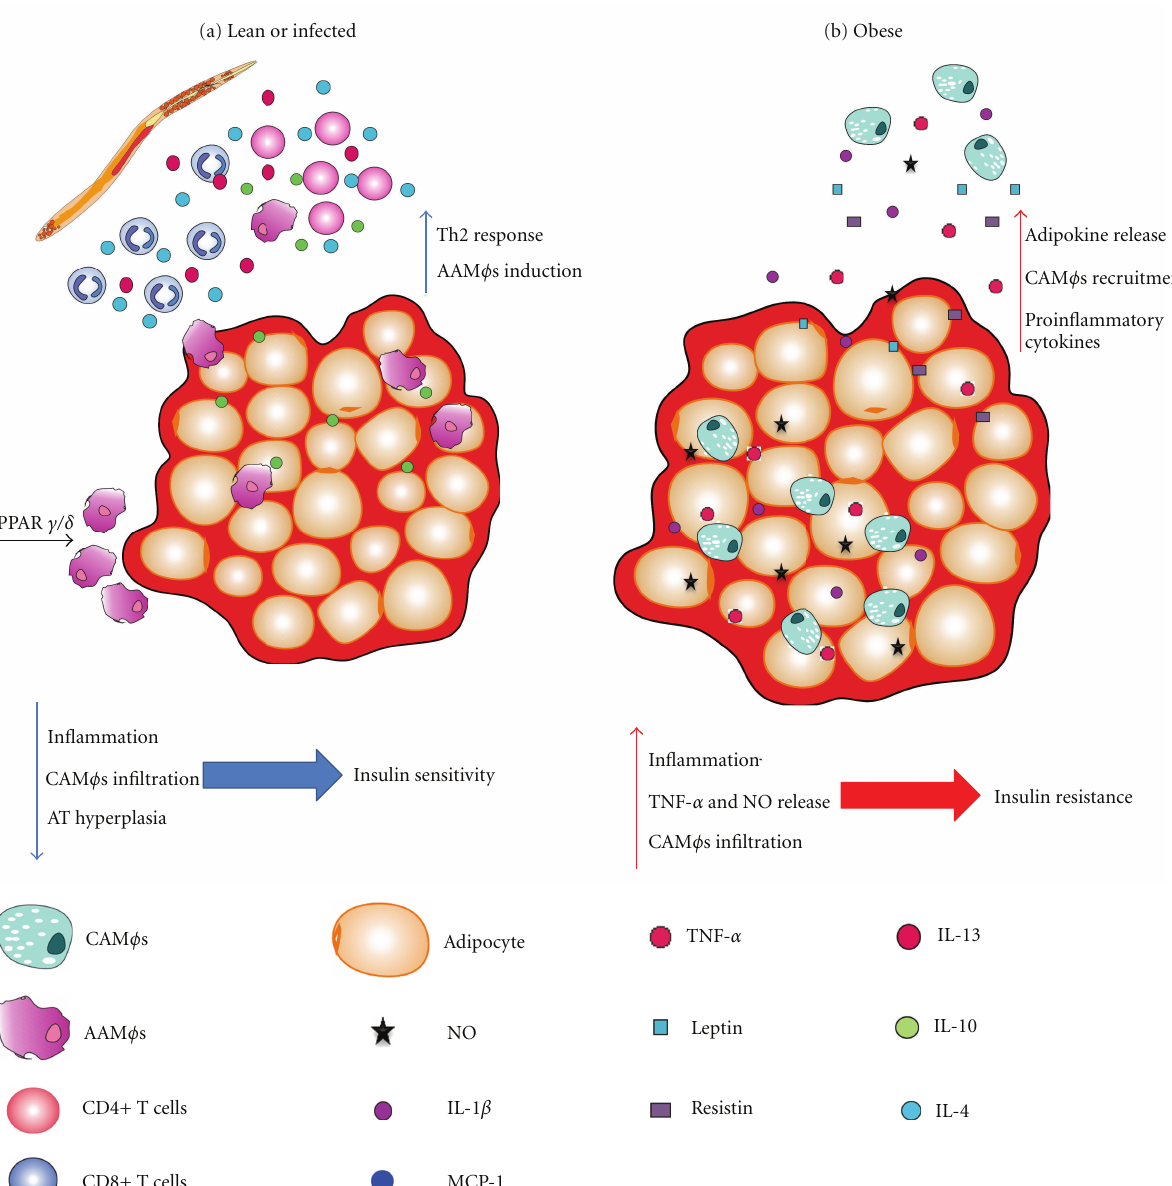
Figure 2: (a) Lean individuals have AAM ϕ s in their AT, which protect them from insulin resistance by secreting IL-10. An helminth infection can recruit Th2 lymphocytes, IL-4/13-secreting eosinophils and AAM ϕ s, thereby increasing protection. The natural AAM ϕ population in the lean AT is sustained by PPAR γ / δ ; (b) obesity induces resistin and leptin secretion, as well as proinflammatory adipocytokines, thereby promoting CAM ϕ recruitment into the AT. CAM ϕ s in turn induce insulin resistance by secreting NO and TNF- α